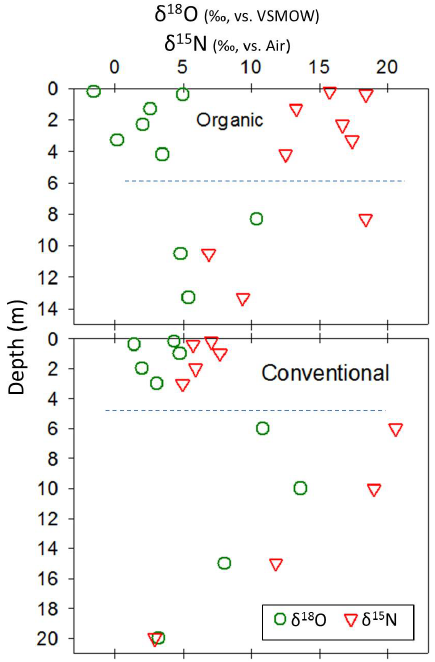
Fig. 4. δ 18 O and δ 15 N profiles of nitrate in the water samples obtained from the vadose zone underlying the organic and con- ventional greenhouses (VSMOW refers to Vienna Standard Mean Ocean